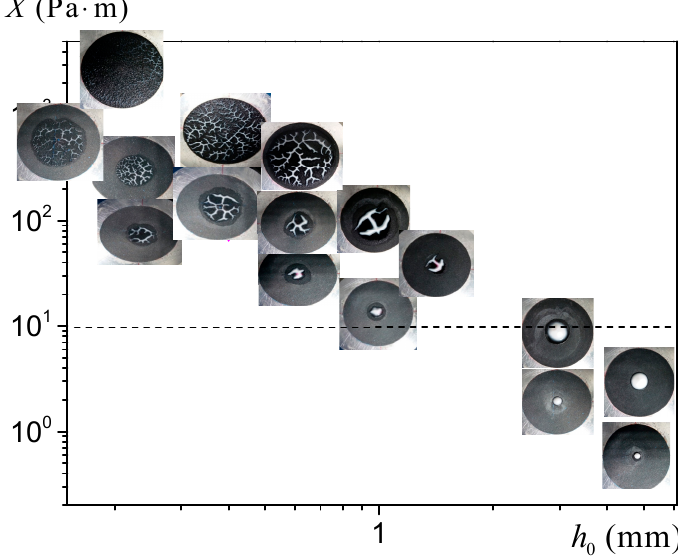
Figure 5. Final aspects of the deposit after plate separation as a function of the parameter X and the initial thickness, for a 40 Pa yield stress emulsion and different sample volumes (the volume corresponding to each picture may be estimated from the value of X and h 0 through Ω 0 = Xh 02 / τ c ). The diameter of the dark disk in all the photos is 10 cm.